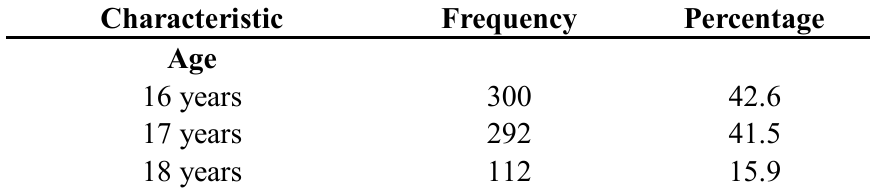
Table 1. Demographic characteristics of study participants from public high schools in the Emawaleni District ( N =